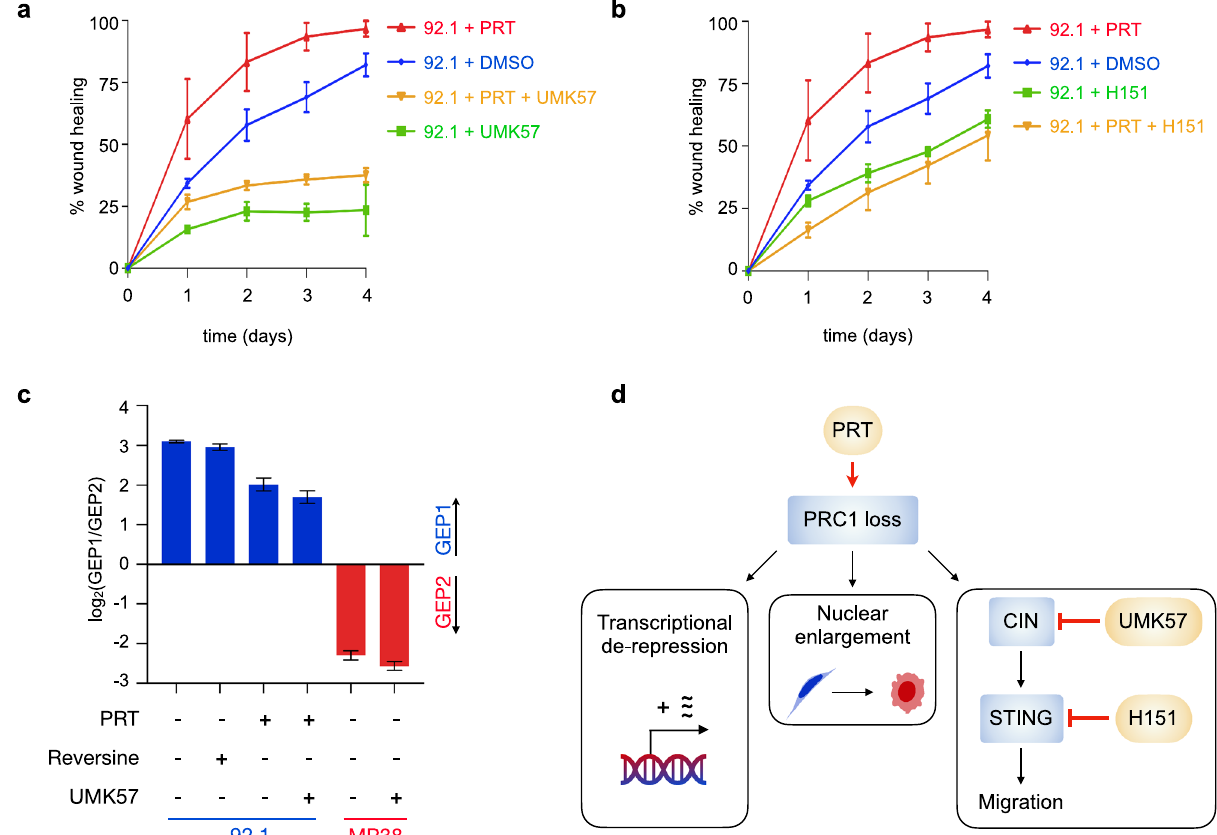
Fig. 8 PRC1 inhibition promotes CIN and STING-dependent migration. a Wound scratch assay to assess migratory potential of low-risk UM cells (92.1) upon treatment with DMSO, PRT, UMK57 (CIN inhibition) or PRT and UMK57. Data obtained from three experimental replicates. Data points, mean; error bars, standard error of the mean. Source data are provided as a Source Data fi le. b Wound scratch assay to assess migratory potential of low-risk UM cells (92.1) upon treatment with DMSO, PRT, H151 (STING inhibition) or PRT and H151. Data obtained from three experimental replicates. Data points, mean; error bars, standard error of the mean. Source data are provided as a Source Data fi le. c Ratio of GEP1/GEP2 average gene signature expression in low-risk UM cells (92.1, blue) and high-risk UM cells (MP38, red) upon 48-h treatment with PRT, reversine (CIN induction) or UMK57; FPKM values obtained from bulk RNA-seq are reported (bar, mean; bars, standard deviation). Biological triplicates. d Schematic of proposed model: Loss of PRC1 ligase activity leads to transcriptional de-repression of target genes contributing to GEP2 phenotype; this concomitantly promotes nuclear enlargement and morphological changes toward an epithelioid phenotype, and enhances migration through CIN-induced STING signaling. Pharmacologic modulators shown in yellow; (PRT, PRC1 inhibition; UMK57; CIN suppression; H151, STING inhibition). CIN, chromosomal